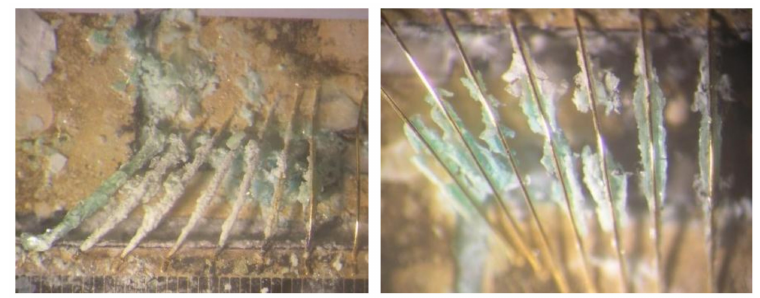
Figure 11. Examples of white spots.